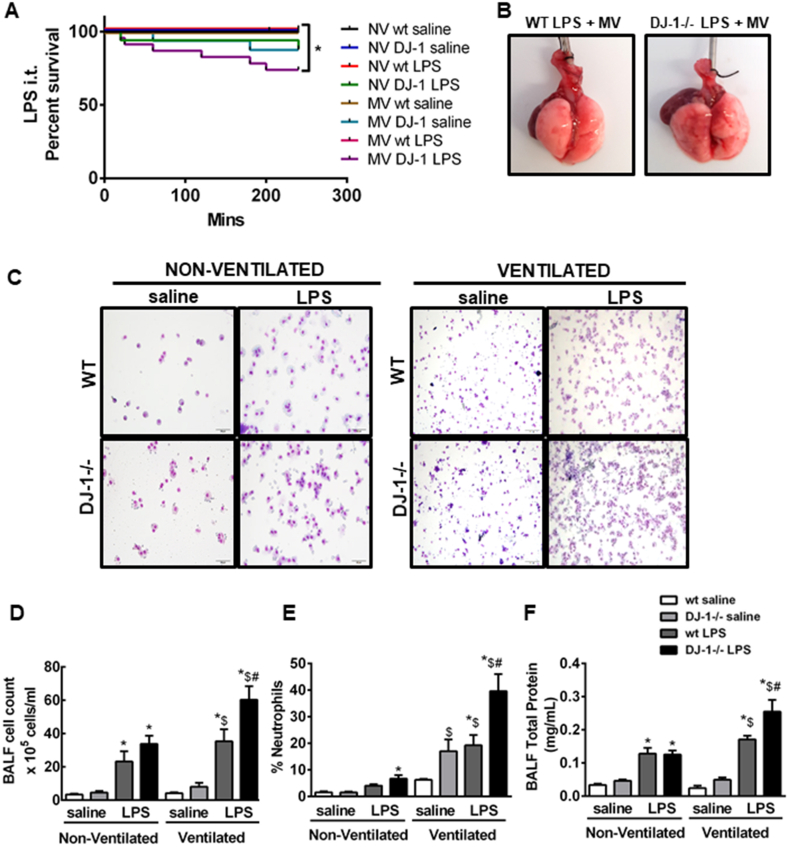
DJ-1 deficiency exacerbated increased lung injury and impaired function in LPS + MV model. A) Percent survival of WT and DJ-1−/− mice at 4 h after saline or LPS instillation with or without mechanical ventilation (MV) (*p < 0.05 Log-rank/Mantel-Cox analysis). B) Representative images of whole lungs from WT and DJ-1−/− mice following LPS + mechanical ventilation (MV). C) Representative images of H & E stained BALF cytospins from WT and DJ-1−/− mice at 4 h after saline or LPS instillation with or without mechanical ventilation (MV). BALF D) total cell count, E) percent neutrophils and F) total protein in WT and DJ-1−/− mice at 4 h post LPS and ventilation. Data are presented as means ± SEM (n = 6–9 saline and 11–17 LPS mice) *p < 0.05 compared with saline control of respective genotype $p < 0.05 compared with non-ventilated LPS group, #p < 0.05 compared with WT LPS ventilated, two-way ANOVA analysis).